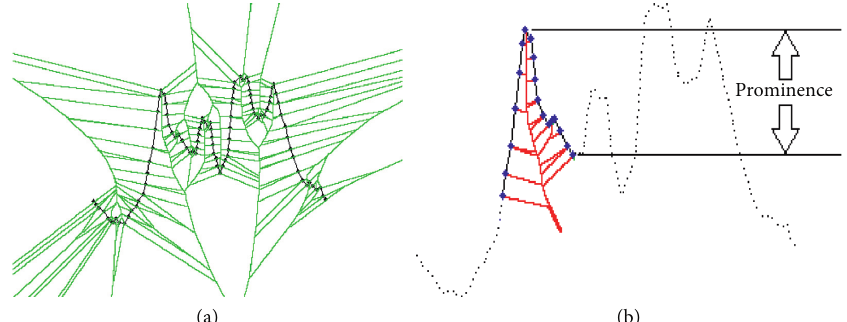
Figure 5: (a) The Voronoi diagram of the data in Figure 4. (b) A Voronoi edge (thick red line) and its descendent edges (thin red lines), representing a hill in the function curve. The height difference between the two black horizontal lines is the prominence of the Voronoi the prominence curve the dot (the yellow dot) farthest from the line. This dot is called the prominence bending dot. The prominence dots before the bending dot represent the peak points detected (Figure 7(a)).